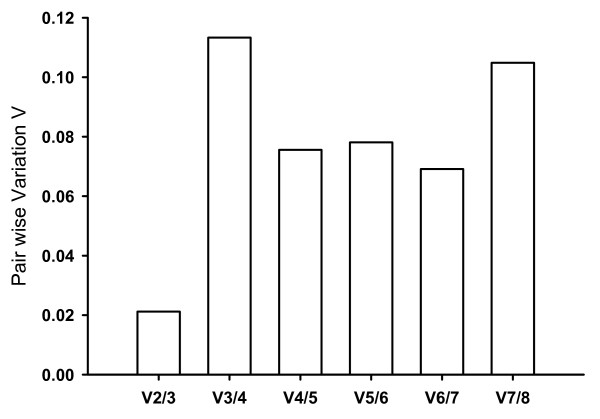
Pair wise variation of sequential normalisation factors (Vn/n+1) in the microcystin experiment estimated by geNorm. V2/3 is based on the geometric mean of the normalisation factors of TBP, 18S and alpha-tubulin; V3/4 is V2/3 and SucDH; V4/5 is V3/4 and actin; V5/6 is V4/5 and GapDH; V6/7 is V5/6 and cyclophilin; V7/8 is V6/7 and UBC, V8/9 is V7/8 and 28S.